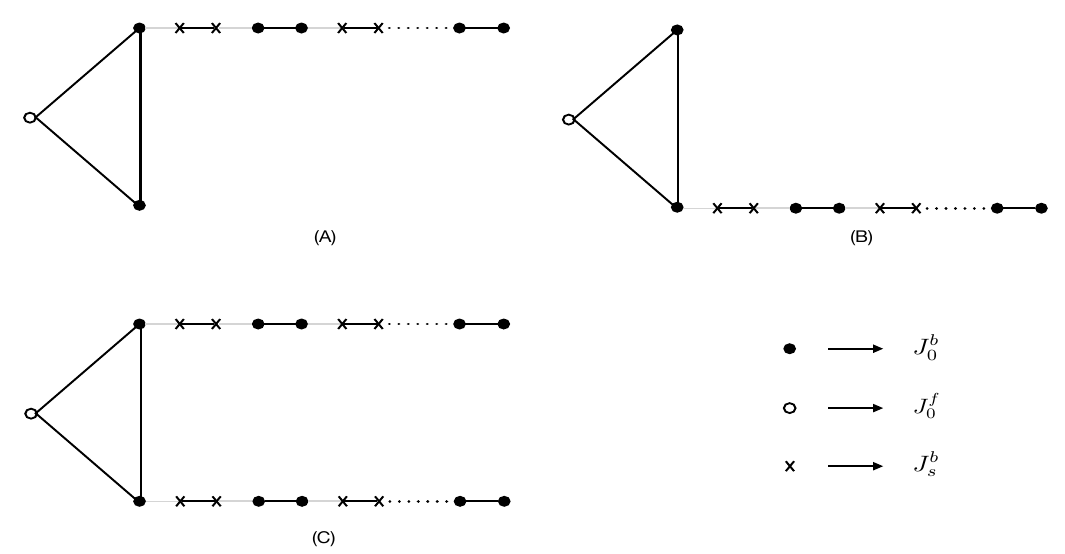
Figure 7 . Schematic representation of 3 type of diagrams contributing to the factorization via the double trace term J b J f in the action. The dots (crosses) connected with solid lines are factorized 0 0 correlation functions while the grey line connecting a dot with a cross means the corresponding operators have same